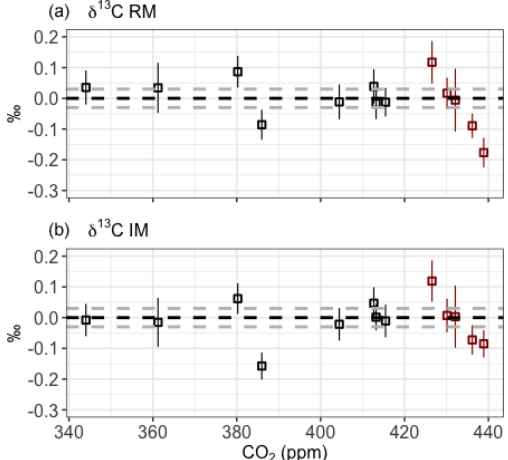
Figure 8. Results of the intercomparison of δ 13 C measurements on the SICAS and on the IRMS facility at the MPI-BGC for both the RM (a) and IM (b) . The MPI-BGC results were subtracted from the SICAS results, and the error bars show the combined uncer- tainty of the SICAS measurements. The dotted gray lines show the 0.03‰ range of residuals. Red data points are outside of the CO 2 mole fraction range of the reference